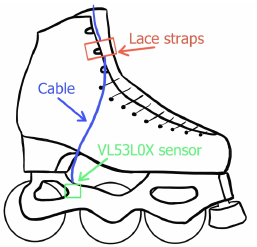
Figure 2. The positioning of the VL53L0X sensor on the boot.